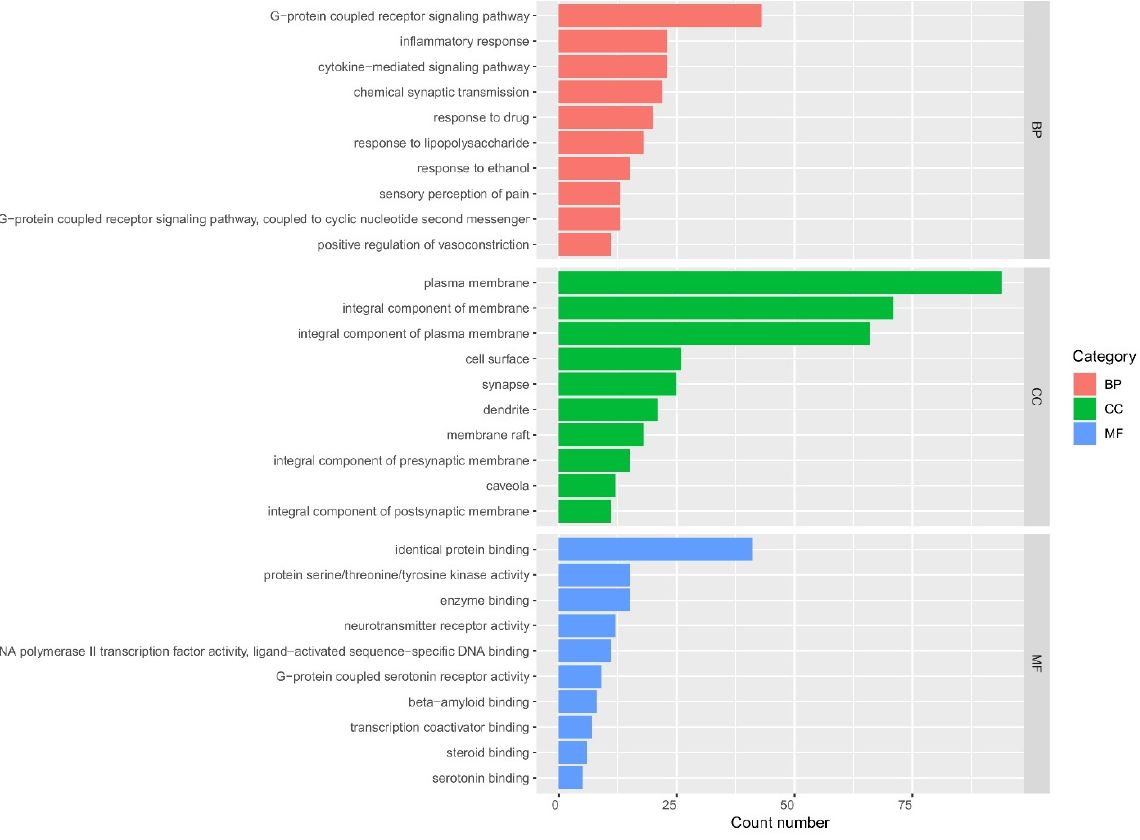
Figure 4. GO enrichment analysis for 50 key targets (BP: biological process; CC: cell component; MF: molecular function).